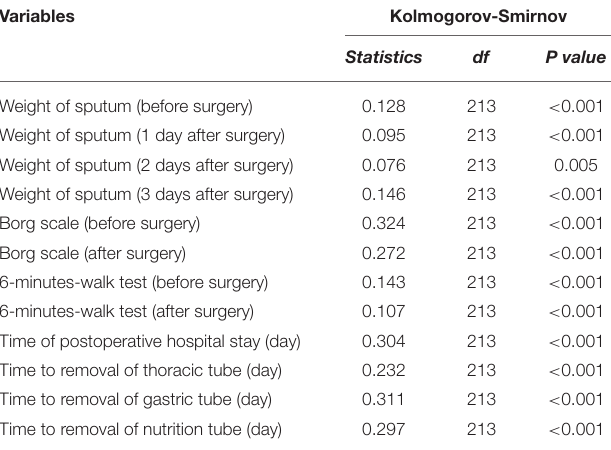
TABLE 2 | Normality test of each